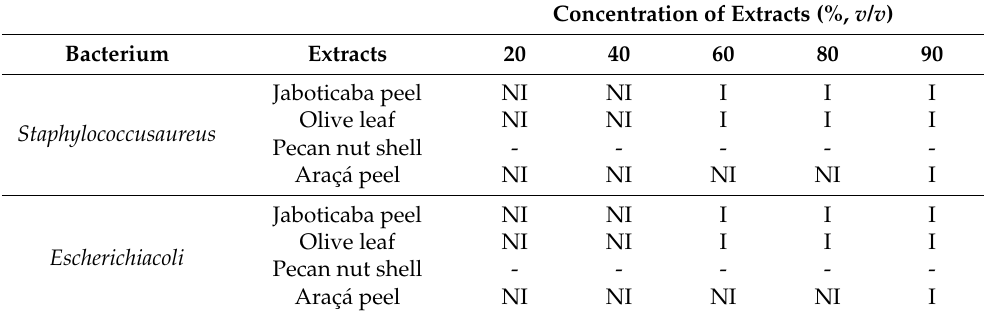
Table 5. Inhibition potential of natural extracts against microorganisms Escherichia coli and Staphylo- coccus aureus .